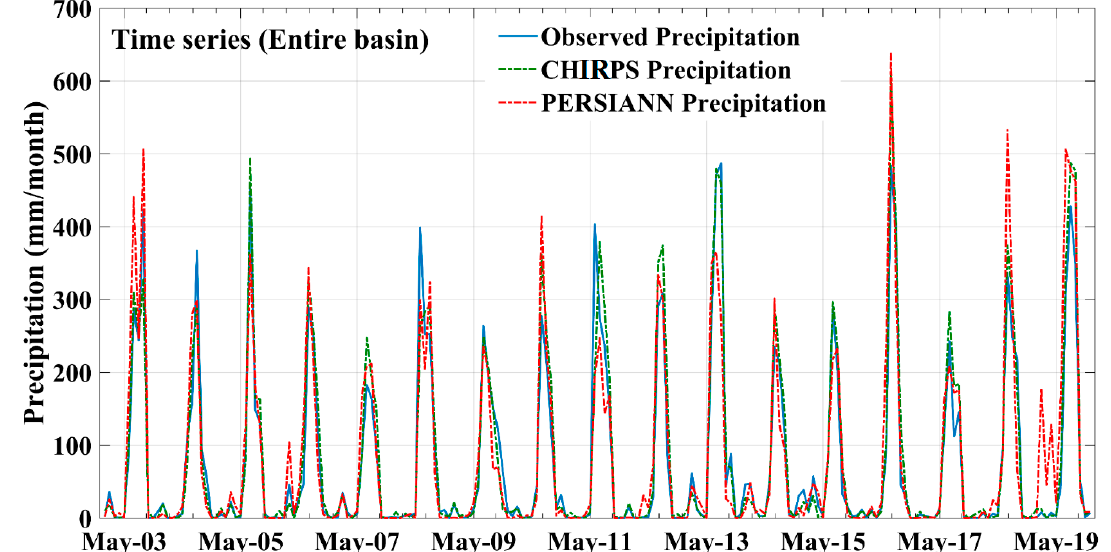
Figure 8. The time series plot of observed (IMD) vs. satellite precipitations (PERSIANN and CHIRPS) datasets for the entire basin over a period from 2003–2019.